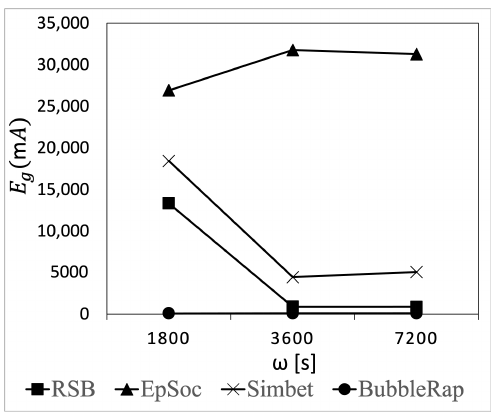
Figure 11. Energy cost ( E g ) as a function of the message generation interval ( ω